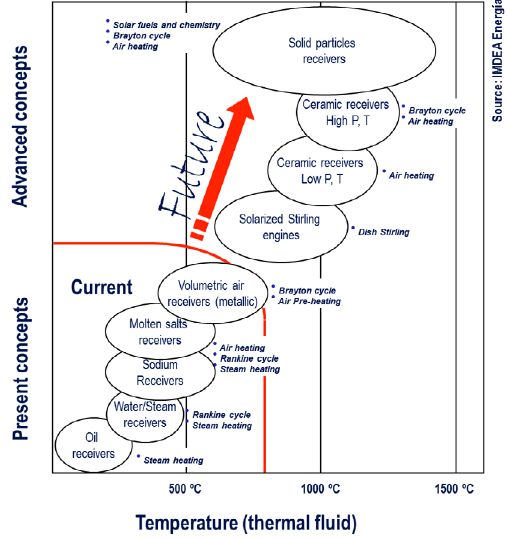
Fig. 6. Concentrating Solar Power (CSP) towards high- fl ux/ high-temperature technologies with ef fi cient